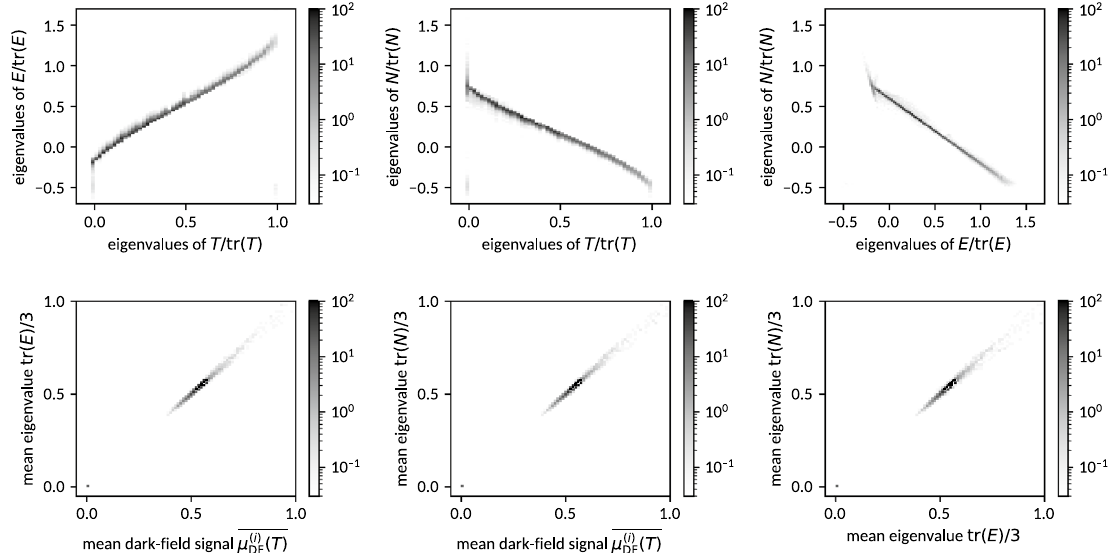
Figure 7. Upper row: Pairwise comparisons of the eigenspectra of tensors describing dark-field anisotropy in different ways (cf. Fig. 3). Instances of N and E have to this end been reconstructed from dark-field signals synthesized from generated instances of T as detailed in Section 3. For each pair among the tensors T , N and E (cf. Eqs. 1–5), their respective normalized and sorted eigenvalues (in reverse order for N ) are plotted against each other in 2D density histograms. Bottom row: Comparisons of mean eigenvalues of N and E to the mean of the dark-field signals they were reconstructed from (left and center panel), as well as comparisons among each other (right